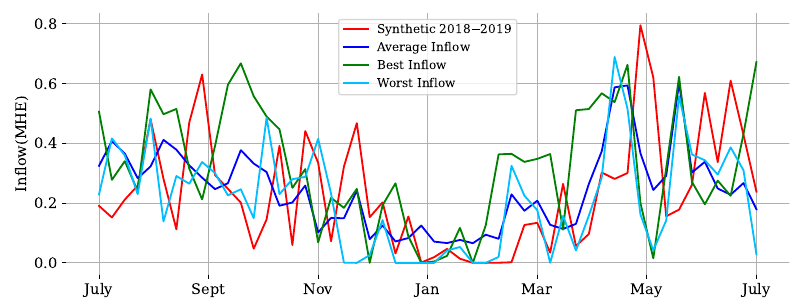
Figure 11. The three cases of inflow scenarios and synthetic inflow of 2018–2019.